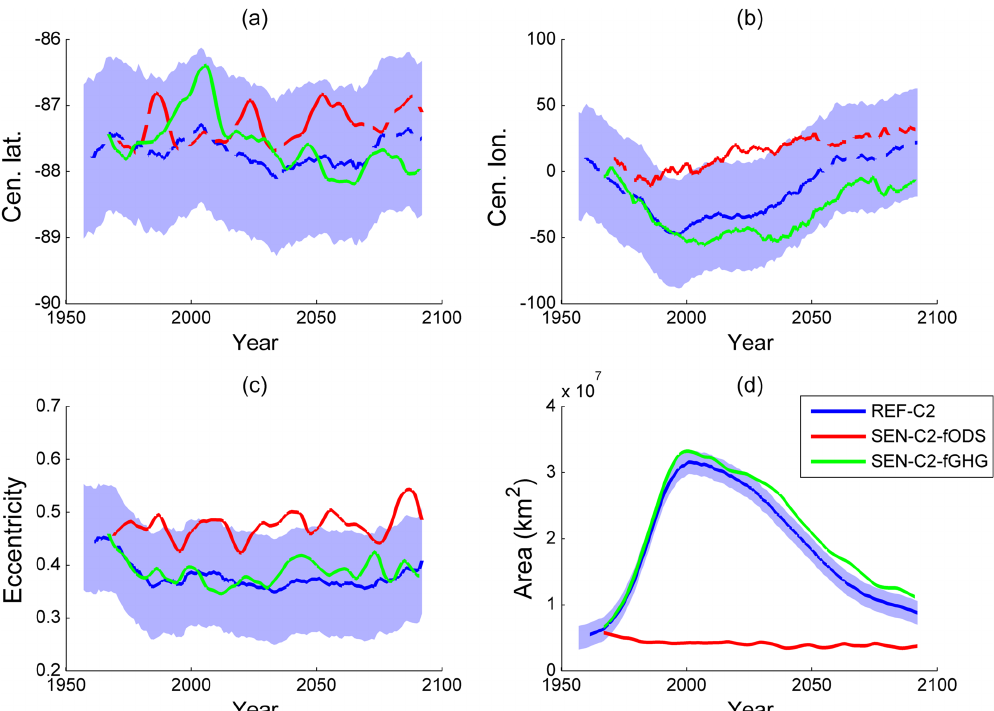
Figure 2. Time series of the October TCO ellipse parameters: (a) centre latitude, (b) centre longitude, (c) eccentricity and (d) area for the REF-C2 (blue), SEN-C2-fODS (red) and SEN-C2-fGHG (green). Lines show the ensemble mean smoothed with a 15-year low-pass filter; the lines are dashed if the difference between the REF-C2 and SEN-C2-fODS is not statistically significant. The shaded region indicates ± 1 SD from the ensemble mean (the other simulations have a similar level of uncertainty but are not shown for